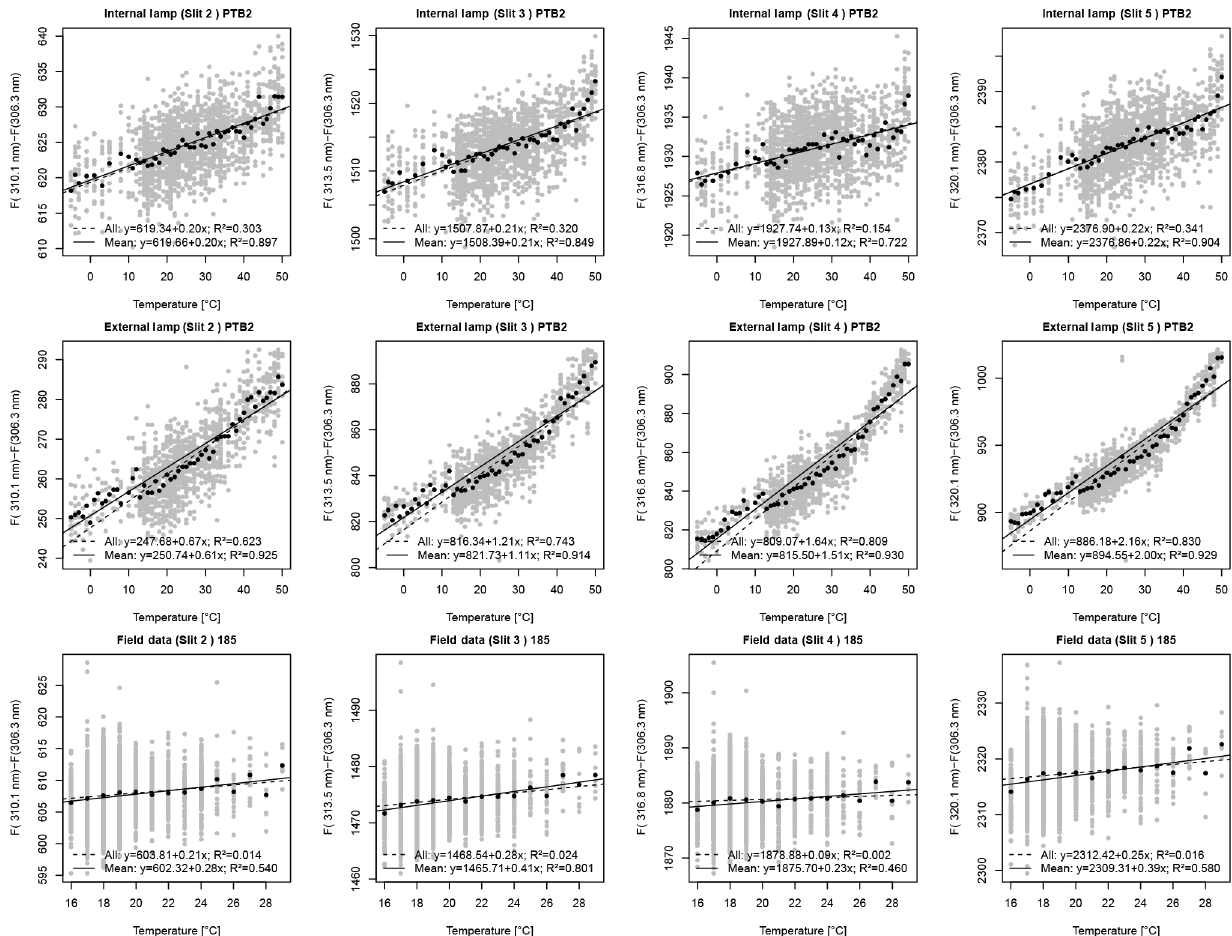
Figure 8. PTB2 experiment. Linear regression between relative Brewer data (slits 2, 3, 4 and 5 relative to slit 1) and temperature. Coefficients are determined from internal and external lamp measurements in the temperature chamber and from field data. Linear regression using individual measurements (grey points) is represented by dashed lines, while solid lines represent the linear regression when using average values at each